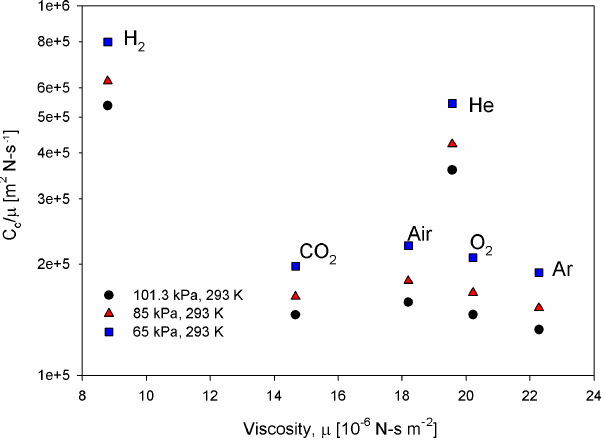
Figure 3. Pressure effect on C c -to- µ ratio for various carrier gases.